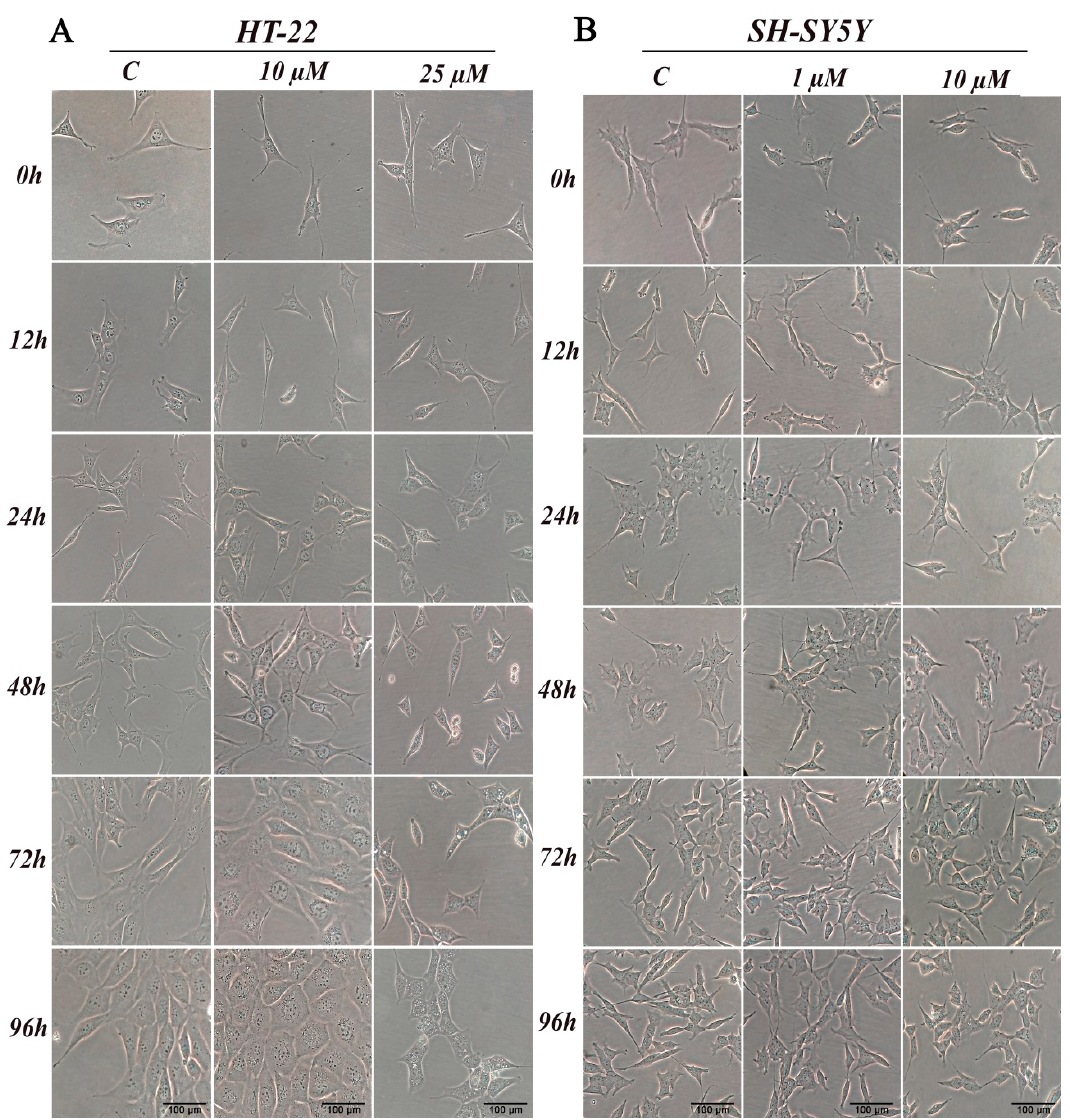
Figure 3. D2AAK1 mediated changes in cell morphology ( A ) HT-22 and ( B ) SH-SY5Y. Cells were treated for 96 h and digital images were captured. Magnification of the objective lens 10×.